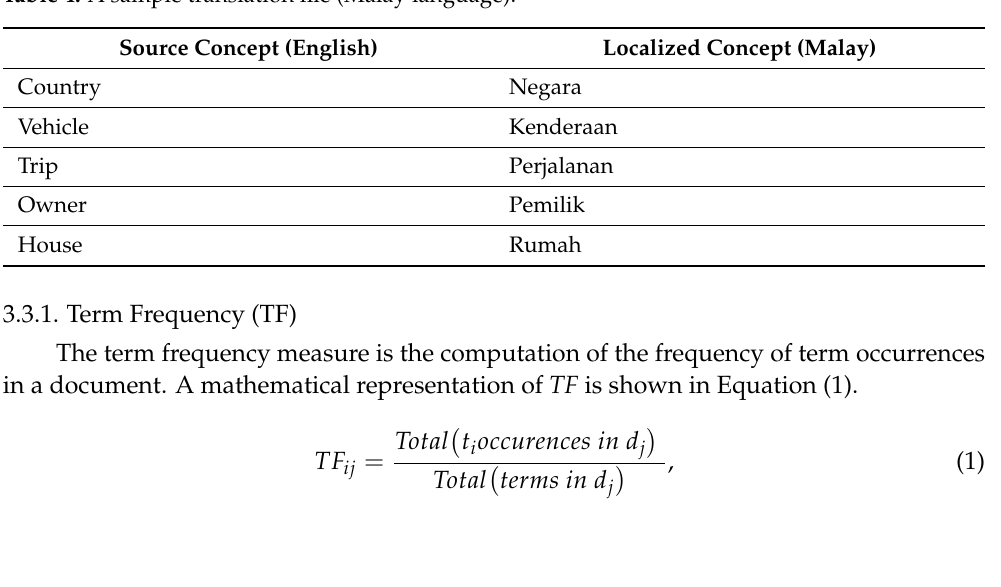
Table 4. A sample translation file (Malay language).